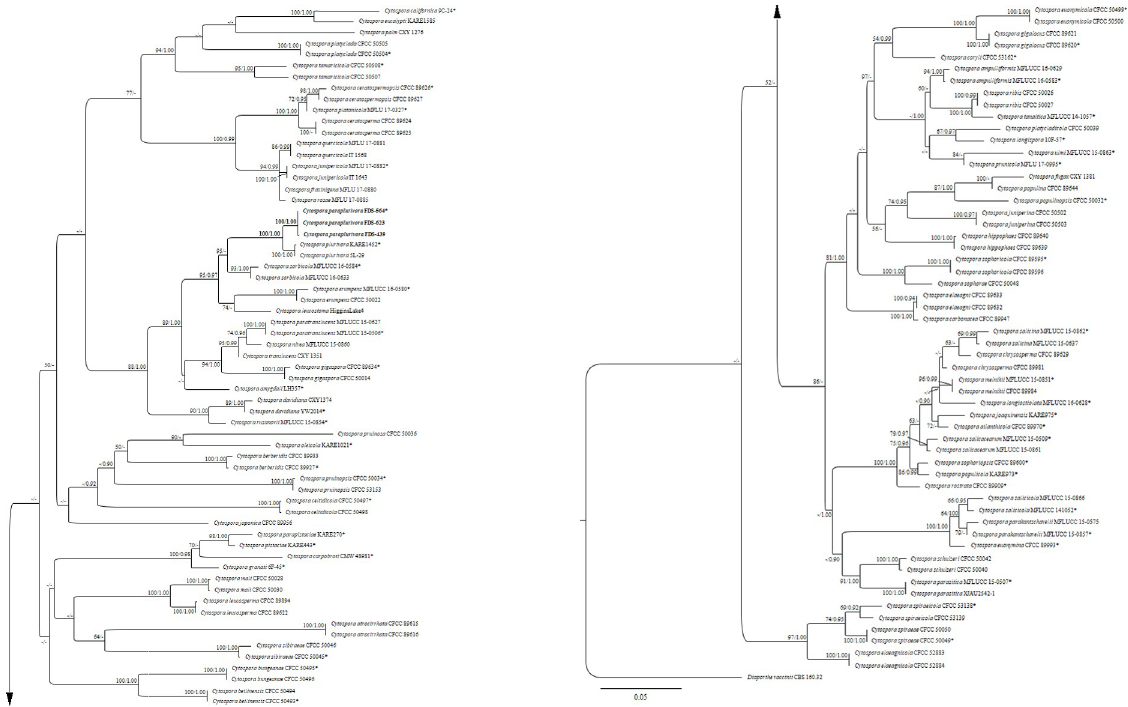
Fig 2. Maximum likelihood (ML) phylogeny based on a concatenated ITS, LSU, act , tef 1- α sequence alignment. Bootstrap support values for ML � 50% and BP � 0.90 are defined as ML/BP above and below the nodes. Strains of the new species are in bold, and ex-type strains are marked with � . The tree is rooted to Diaporthe vaccinii (CBS 160.32).